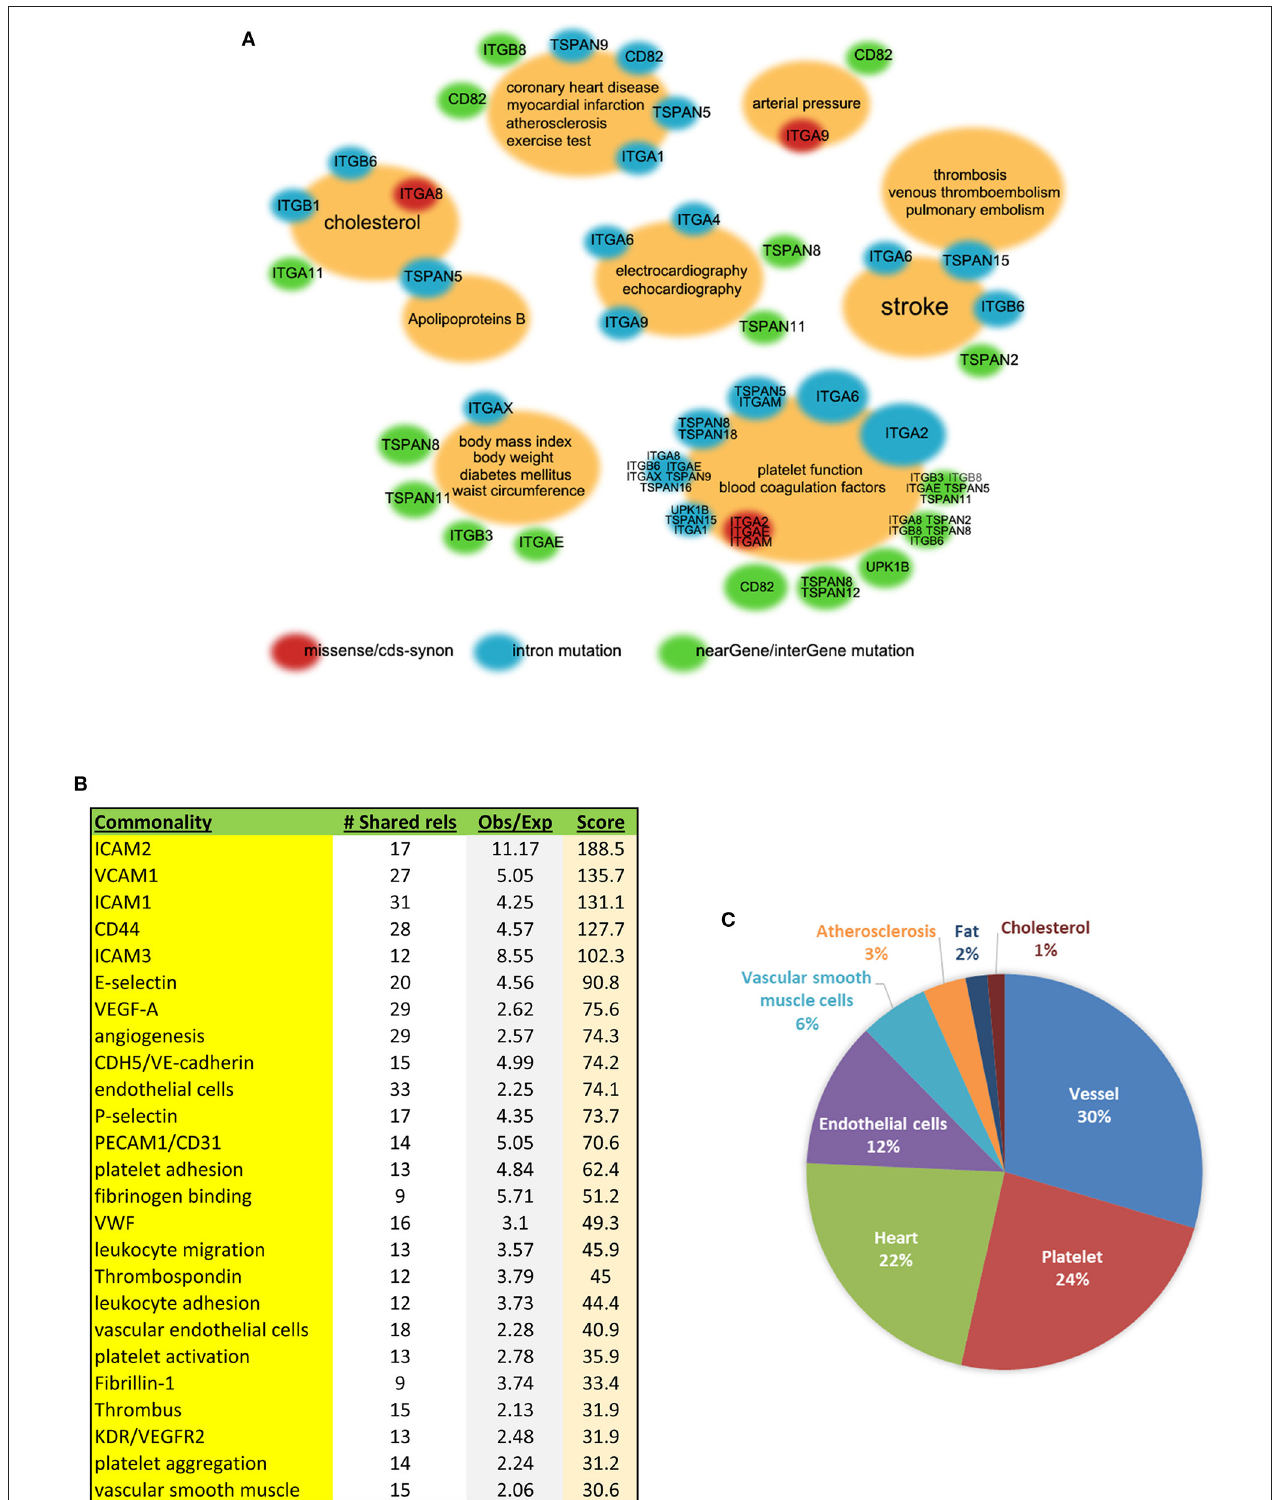
FIGURE 3 | Integrin and/or tetraspanin genes associated with multiple cardiovascular phenotypes in humans. (A) Association clouds with GWAS phenotypes at the centers and related genes at the surrounding. Small red clouds with gene names denote an association between a missense and/or cds-syn mutation(s) of the